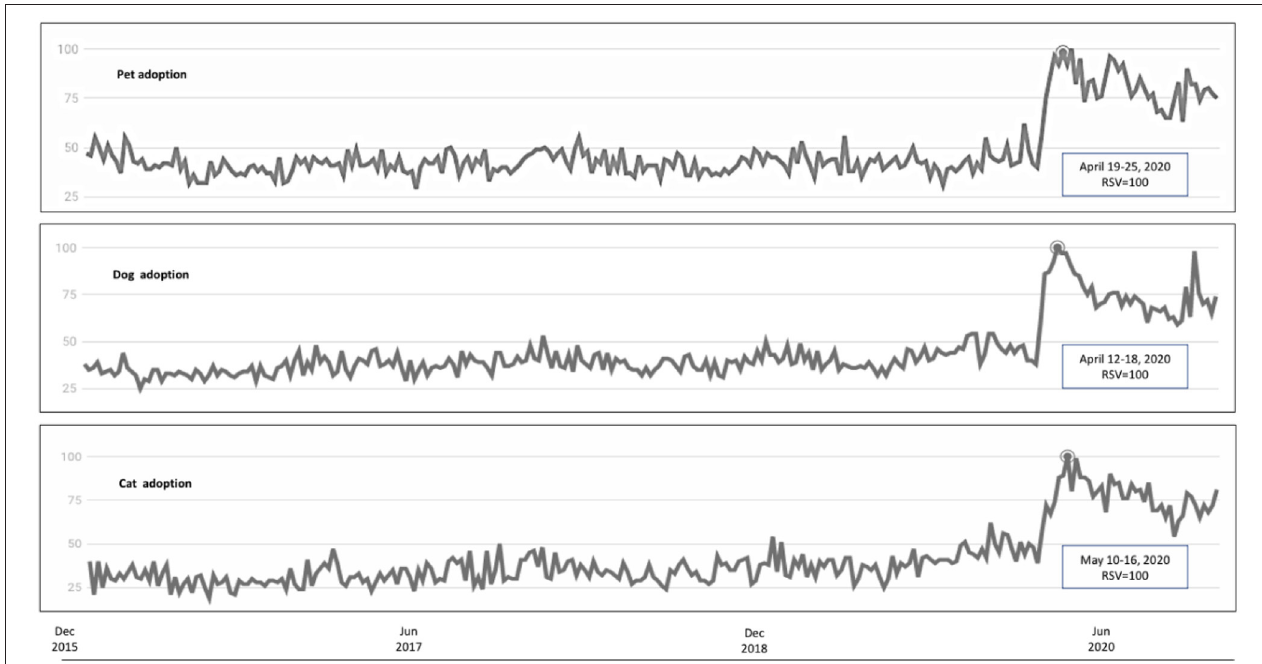
FIGURE 1 | Relative search volume of pet adoption related key words between December 2015 and December 2020. The panels from top to bottom indicated the searches for pet adoption, dog adoption, and cat adoption, respectively. Peaks as indicated by rectangles were observed following the WHO declaration of the COVID-19